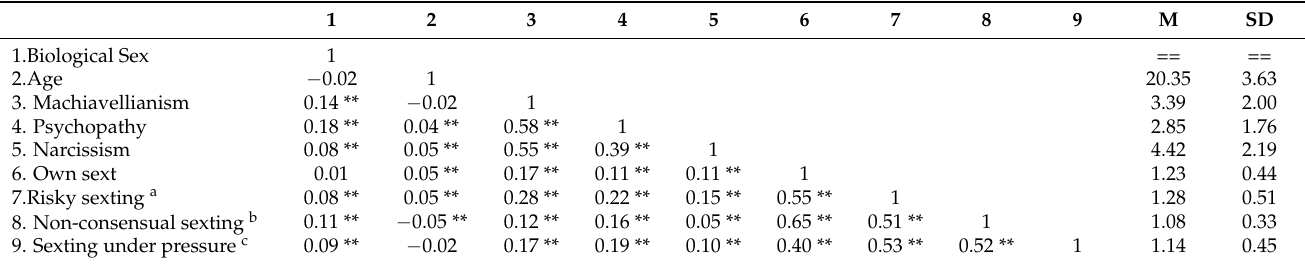
Table 4. Correlations among